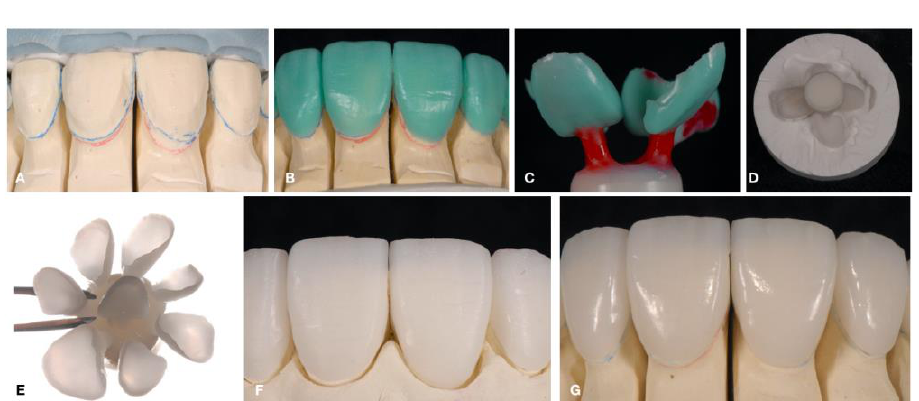
Figure 1. Layering technique. ( A ) Polycrystalline Framework; ( B ) Feldspathic ceramic build-up (wash bake); ( C ) Feldspathic ceramic build-up (intensive chrome + dentin); ( D ) Feldspathic ceramic build-up (enamel layer); ( E ) Feldspathic ceramic after firing; ( F ) Feldspathic ceramic after thermal and mechanical glaze.